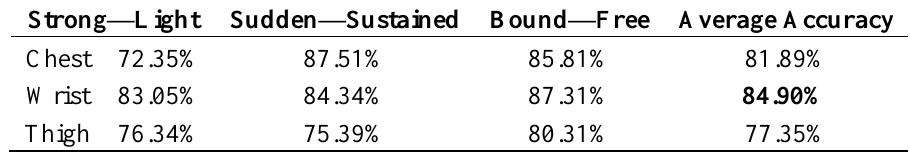
Table 9. The average accuracy for each location to detect all subcategories within the Effort